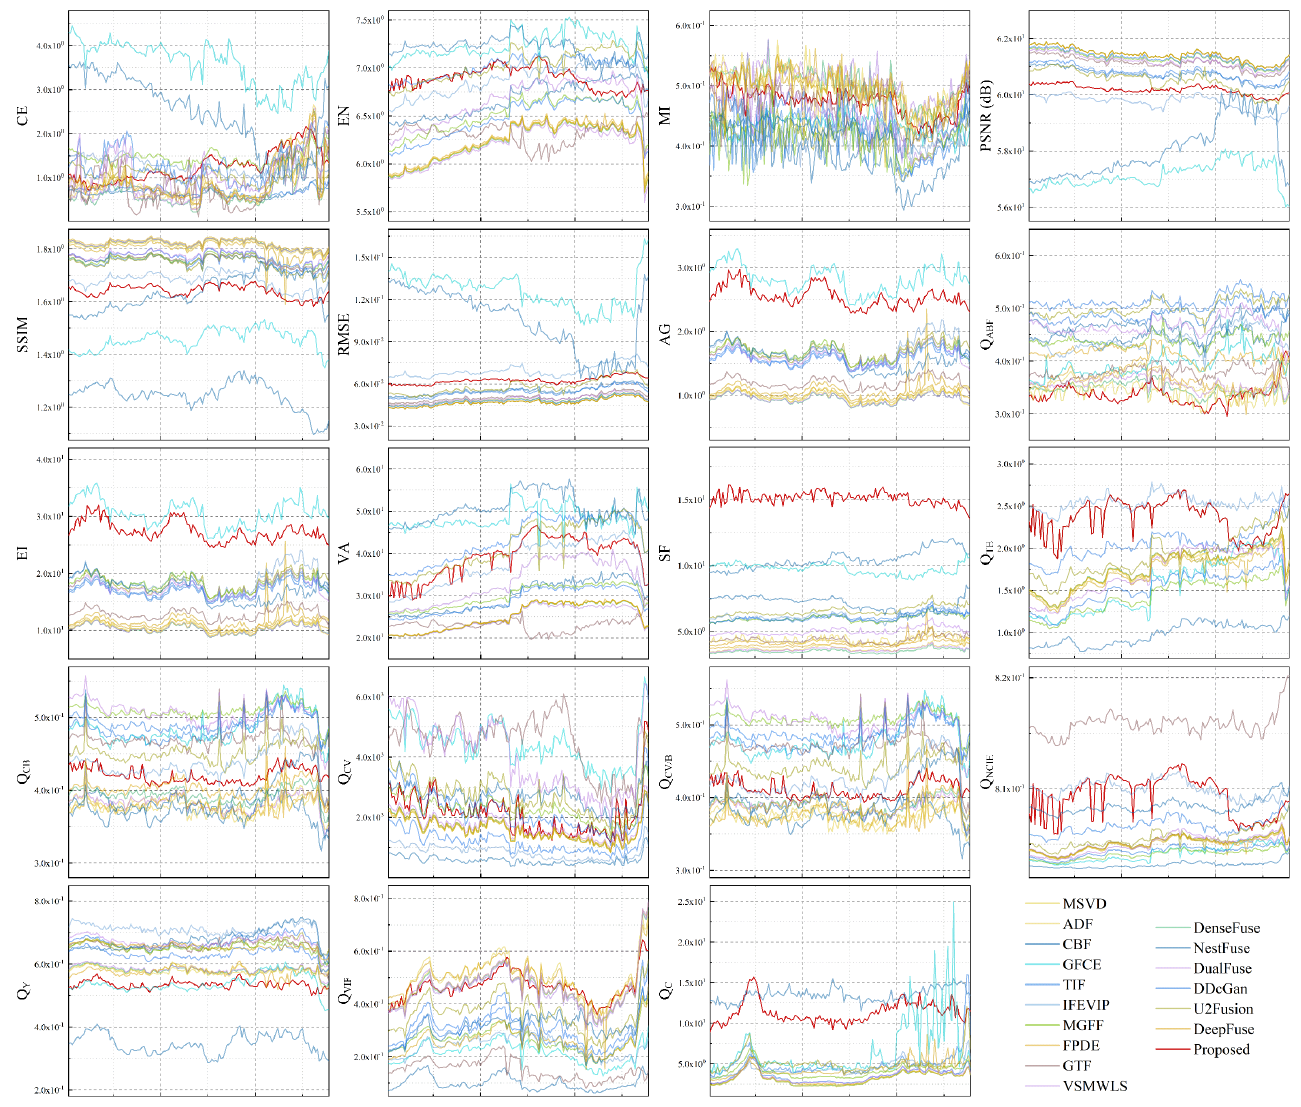
Figure 9. Dynamic changing trends with different metrics (the horizontal axis represents the image frame).